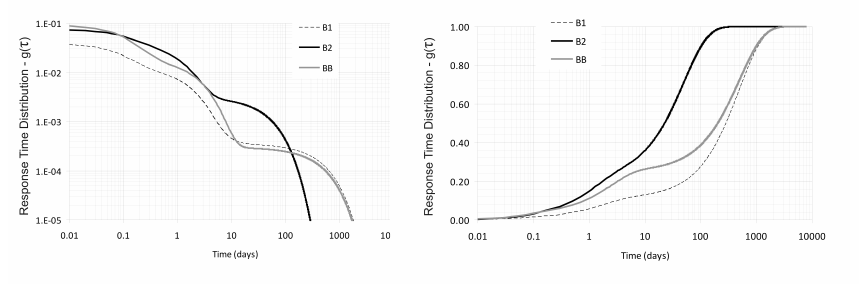
Fig. 4. Response Time Distribution – RTD for the three catchments for event 2: probability density function – pdf (left), cumulative density function – cdf (right).